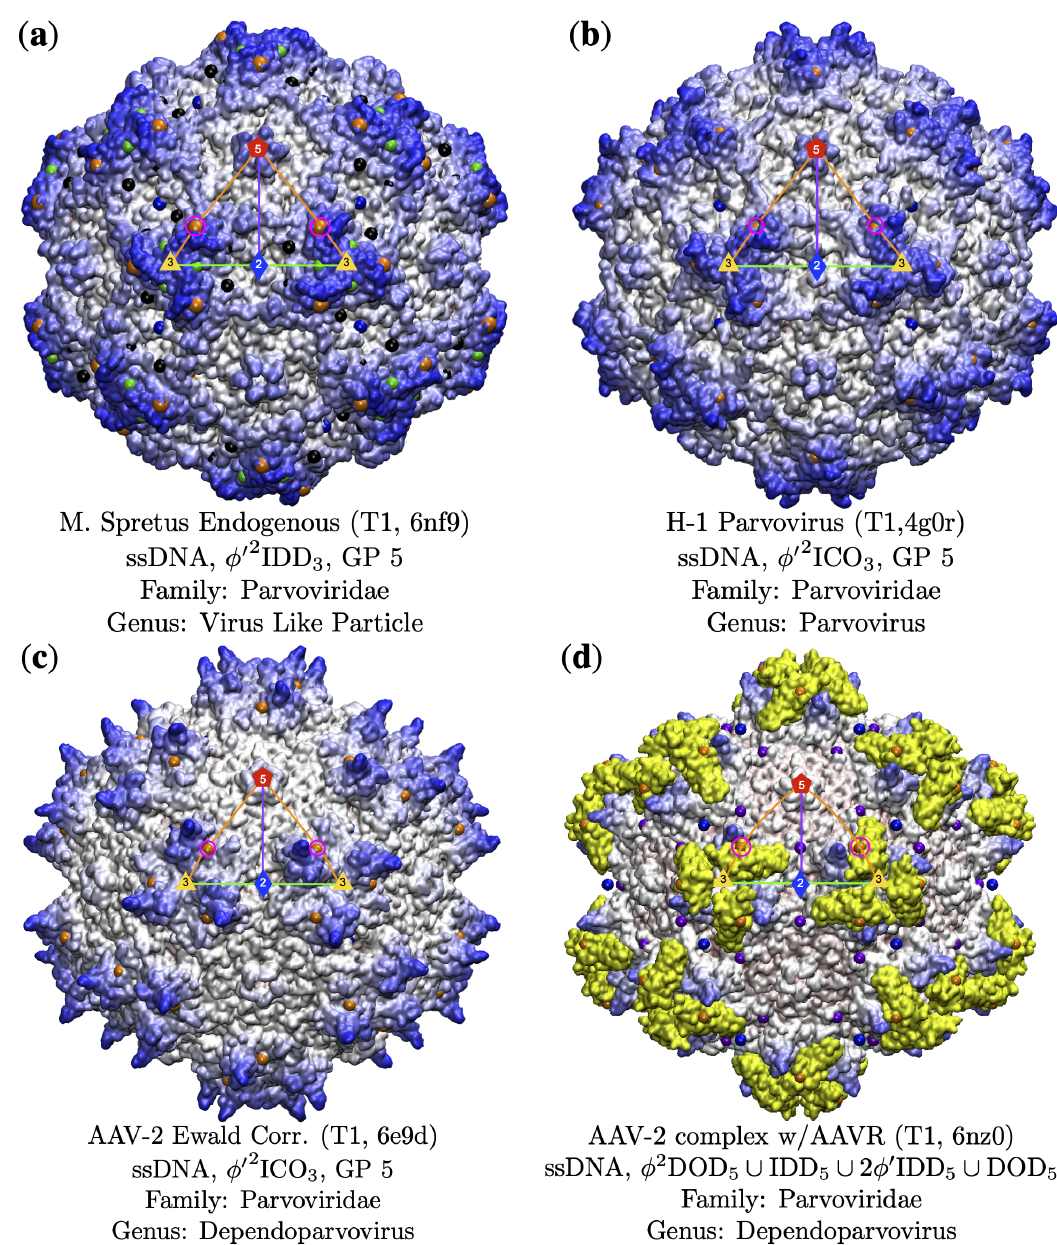
Figure 9. The Parvoviridae Family are non-enveloped T1 capsids with ssDNA that infect a wide range of hosts from vertebrates and invertebrates [48] and all use gauge point 5, making up 8 of the 11 viruses at this location. As you can see in these images, their surfaces vary; however, they all use the exact same gauge point 5 for their structural protrusions. ( a ) M. spretus is a VLP which was discovered as an endogenous viral element. ( b ) The H-1 parvovirus capsid has biomedical applications [50]. ( c ) Adeno-Associated Virus (AAV2) has protrusions that are slightly shifted off GP 5 and was found using cryoEM [51]. No other gauge points and associated point arrays fit this structure. ( d ) Adeno-Associaed Virus in-complex with its cell receptor AAVR, shown in yellow [52]. This combined structure still used GP 5; however, we see that the internal arrangement of constraints has shifted outer point arrays from φ (cid:48) 2 ICO 3 to φ (cid:48) 2 DOD 5 , which is the sister array at GP 5 with one interior radial-level difference